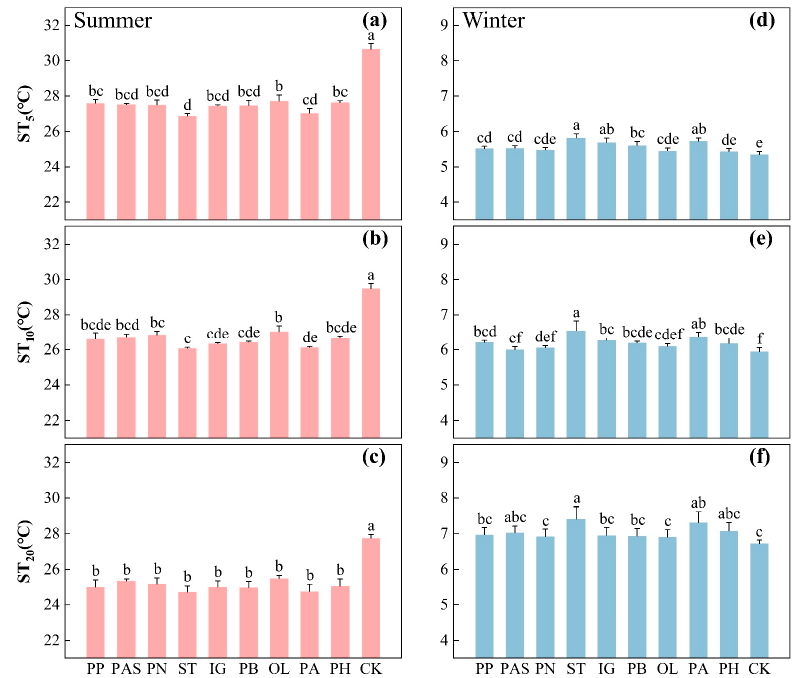
Figure 5. The daily averages of the different bamboo plant communities and the CK in summer and winter. ( a ) Daily average ST at a 5 cm depth in summer; ( b ) Daily average ST at a 10 cm depth in summer; ( c ) Daily average ST at a 20 cm depth in summer; ( d ) Daily average ST at a 5 cm depth in winter; ( e ) Daily average ST at a 10 cm depth in winter; ( f ) Daily average ST at a 20 cm depth in winter.